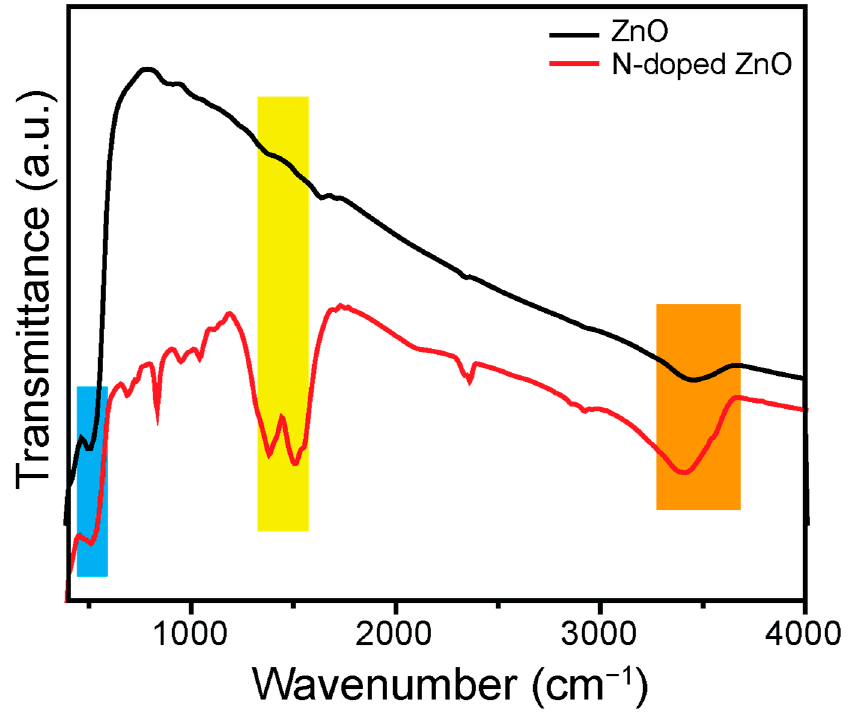
Figure 2. FTIR spectra of the ZnO and N-doped ZnO.